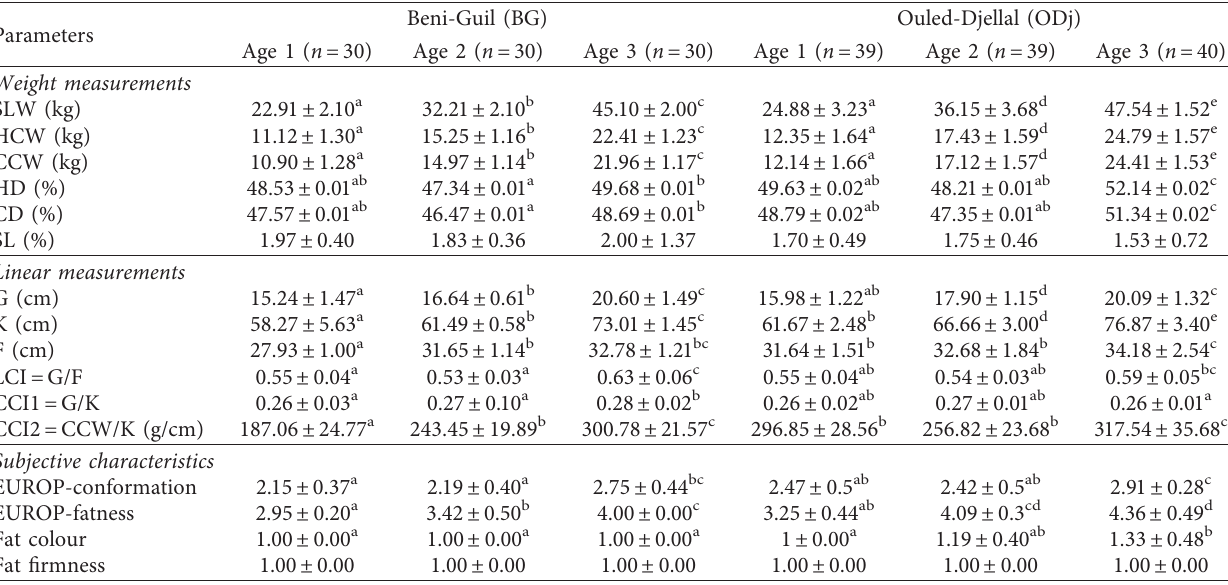
Table 1: Effect of breed and age at slaughter on carcass traits of Beni-Guil and Ouled-Djellal sheep breed from eastern Morocco (means ± SD).